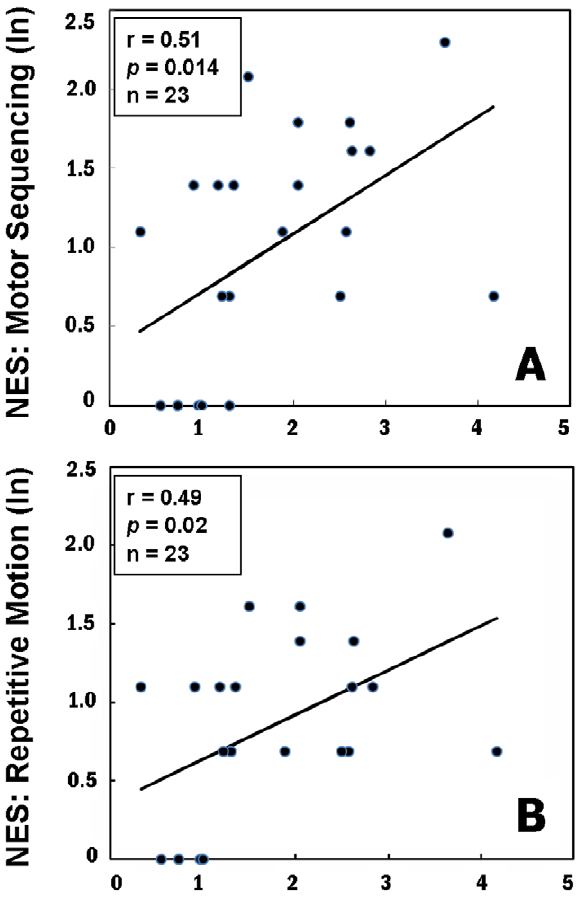
Figure 3. Kendall tau rank correlations between BPRS-thought disorder and guanosine levels (A), and Pearson correlations between NES-sensory integration and uric acid levels (B) in first-episode neuroleptic-naı¨ve patients with schizophrenia (FENN-SZ) at baseline. The BPRS and NES data were available at baseline from 23 FENNS-SZ.